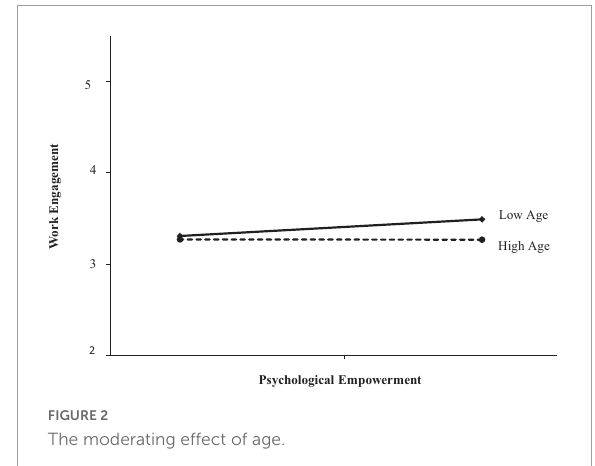
FIGURE2 The moderating effect of